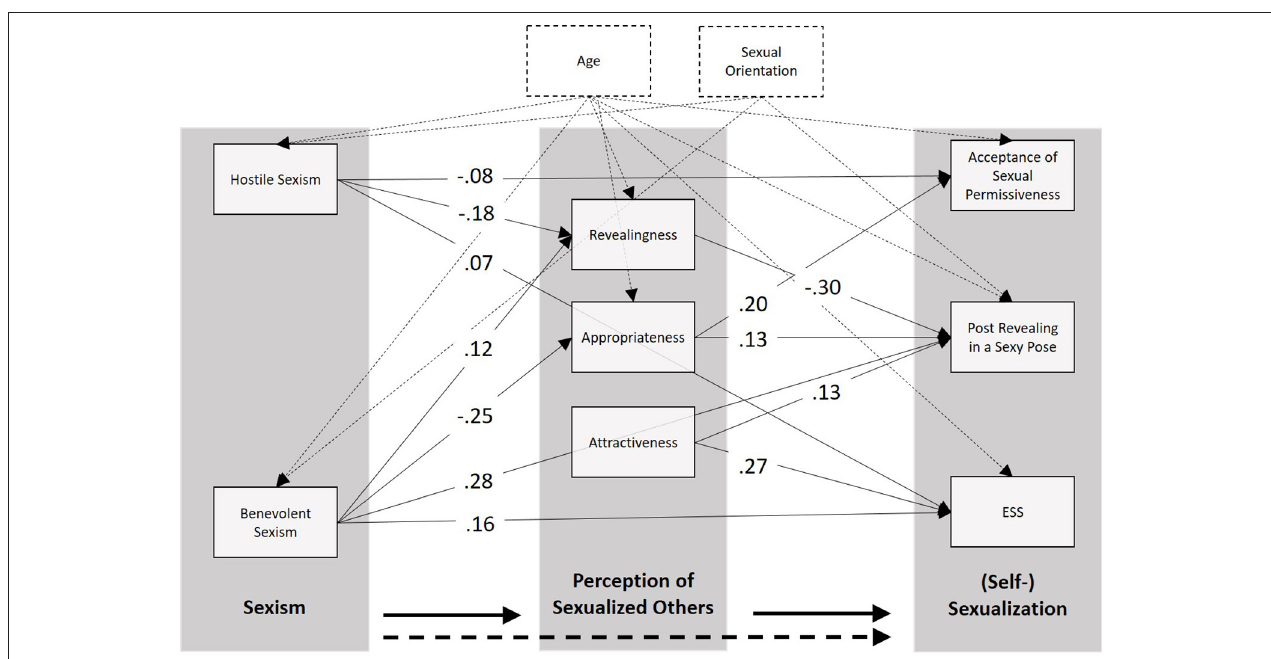
FIGURE 3 | Final path model (chi 2 = 23.71, df = 21, p = 0.307; RMSEA = 0.014) from ambivalent sexism (hostile and benevolent) via the mean evaluations of the presented Instagram photos (as revealing, appropriate, and attractive) to (self-) sexualizing behaviors and attitudes. All shown paths are significant at p < 0.05; for a better readability of the figure, the coefficients for the control variables age and sexual orientation are not depicted.